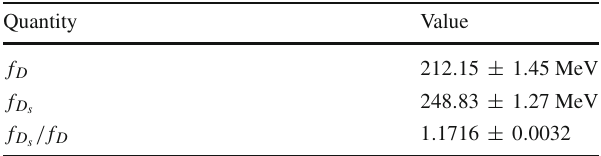
Table 281 The LQCD average for D and D s meson decay constants and their ratio from the Flavor Lattice Averaging Group [222]